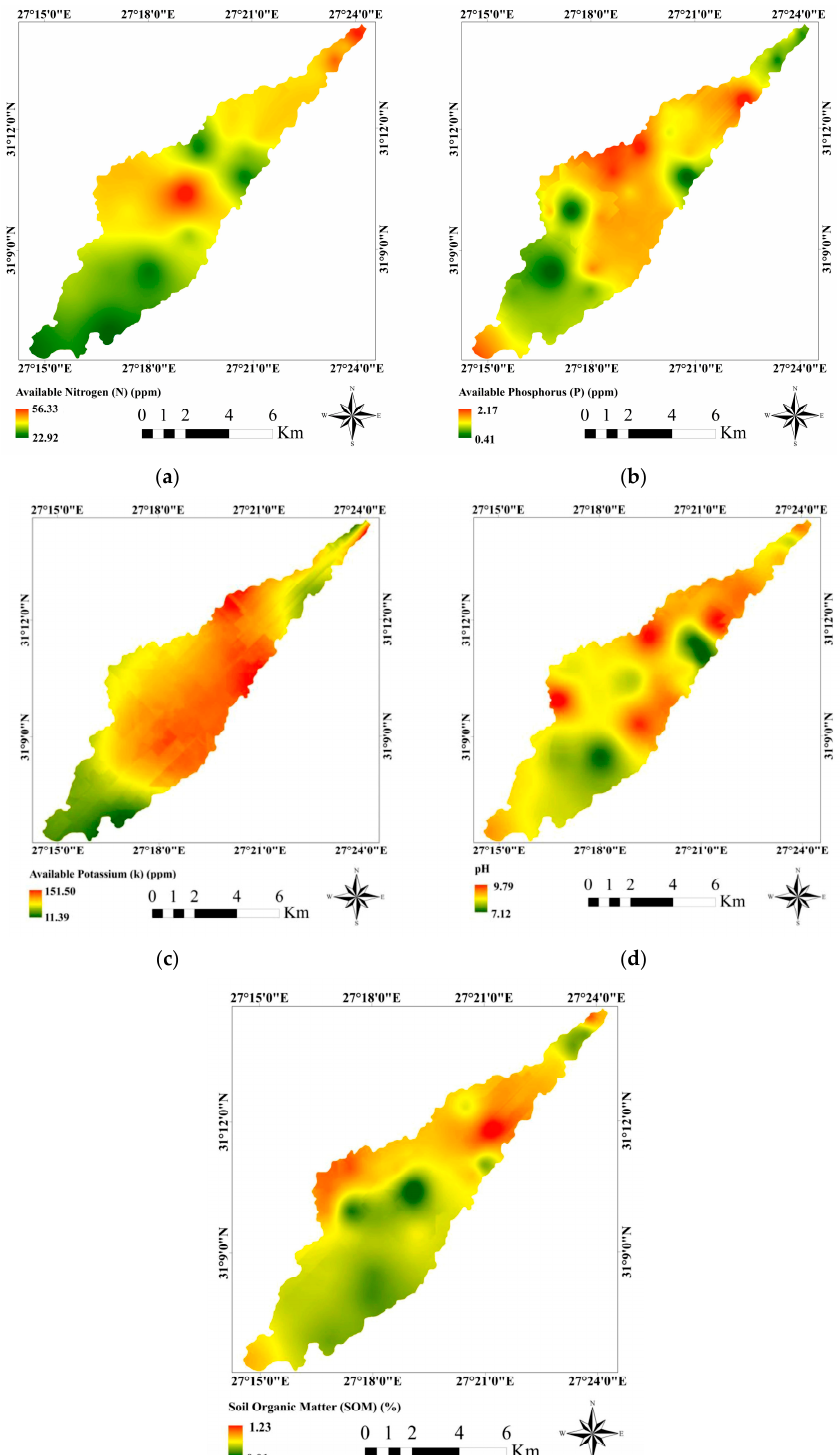
Figure 4. Spatial distribution of predicted soil properties ( a ); predicted available nitrogen (N); ( b ) predicted phosphorus (P); ( c ) predicted available potassium (K); ( d ) predicted pH; ( e ) predicted soil organic matter (SOM)